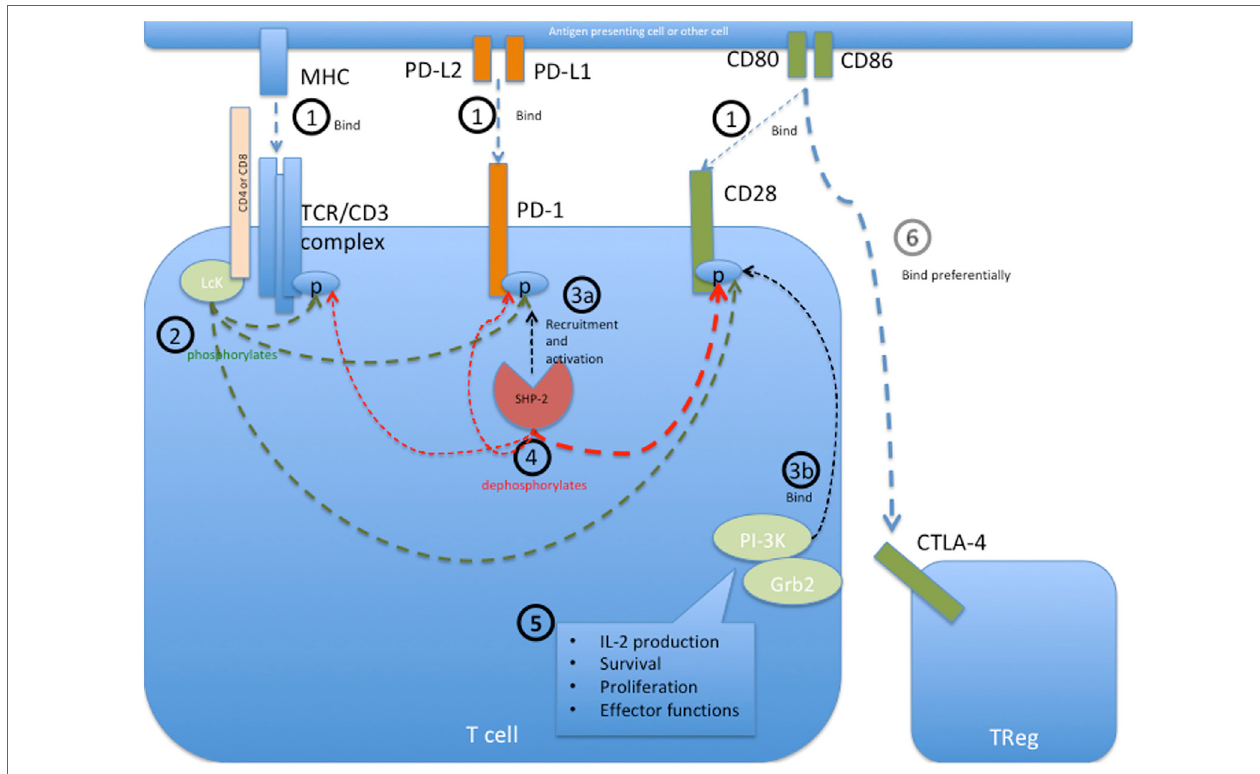
FiGURe 1 | Programmed cell death protein 1 (PD-1) mediated intracellular signaling events during T cell activation. (1) Upon T cell activation, the extracellular receptors PD-1, CD28, and the T cell receptor (TCR) complex (including CD4 or CD8) bind their ligands PD-L1 or PD-L2, CD80 or CD86, and major histocompatibility complex (MHC) class I or II, respectively. This brings all the receptors into close proximity with each other at the immunological synapse and allows them to interact with each other. (2) The Src kinase Lck (P56Lck), which is bound to the intracellular tail of CD4 and CD8, can now phosphorylate the